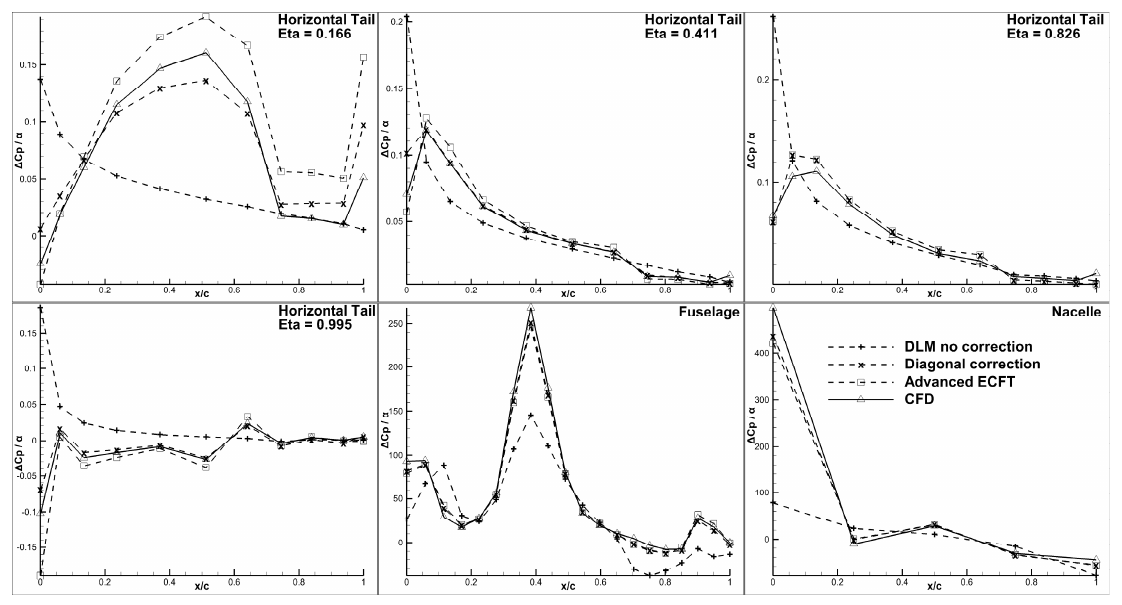
Figure 9. Elastic Δ Cp for a unit α at Wing Component